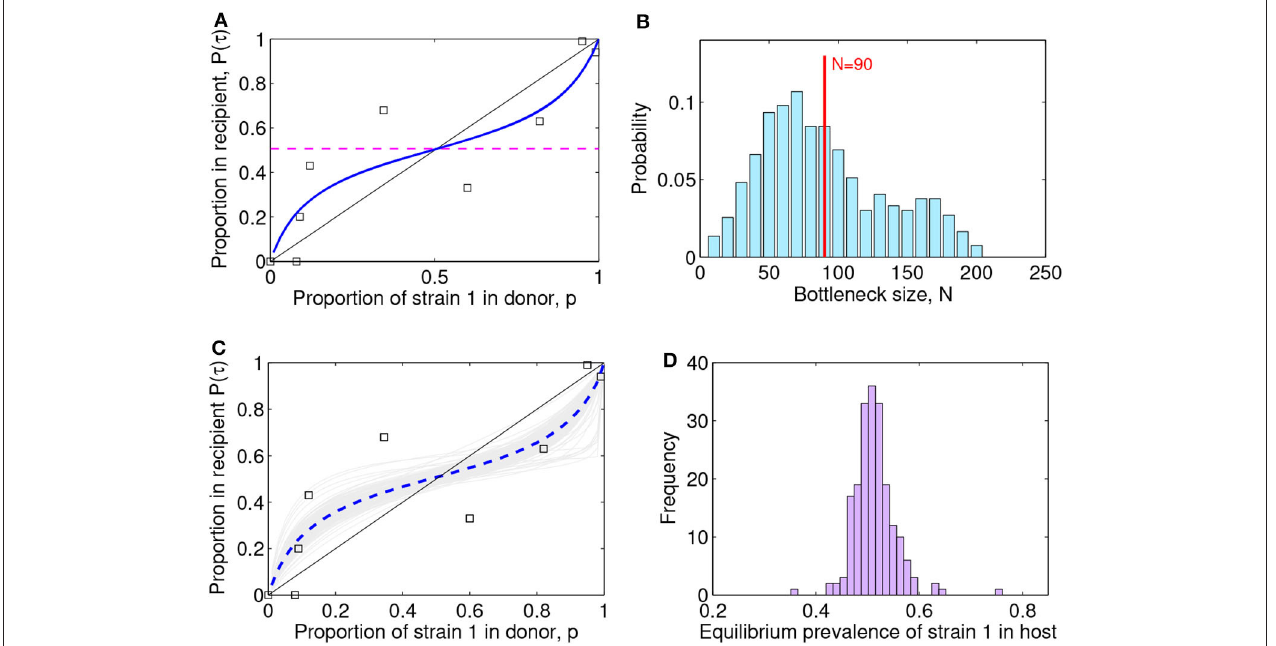
FIGURE 4 | Lotka-Volterra model fit to the (McCaw et al., 2011) ferret transmission data. (A) Fit result with best parameter estimate [ ρ , a 12 , a 21 , β ] = [1.00, 0.25,0.31,0.94], MSE = 0.022. The squares indicate the data, the blue line the model fit, and the dashed purple line the predicted within-host coexistence equilibrium between the two strains. (B) Maximum-likelihood bottleneck size estimation N after filtering simulations and fits. The values of N ∈ [10,200] were ranked based on: (i) the model quality of fit (mean-squared-error of new fit within 20% of the original MSE) and (ii) the capture of the data (proportion of original data points contained within the range of ten N -based stochastic simulations). We multiplied the two criteria for ranking N , and applied a moving average to smooth over N , and a standard normalization to transform the values into probabilities. The mean value estimated for the bottleneck is N = 90 (vertical red line) and the standard deviation is 45, thus suggesting the range N ∈ (45,135) as the most compatible with these data and this model. The mode of the distribution is N = 70. (C) Visualization of 200 model fits (gray lines) to simulated data, varying the initial proportion transmitted from donor to recipient according to bottleneck sizes N sampled from the distribution in (B) . The dashed blue line indicates the mean over all the simulation fits. The squares indicate the data. (D) Model predictions for the within-host prevalence of the mutant strain in coexistence (Equation 8), integrating stochasticity and variation expected from N in (C) . TABLE 1 | Summary of parameter estimates from nonlinear least squares optimization, applying the model to the original data ( Figure 4A ), without considerations of bottleneck size, and fits to simulations with an explicit bottleneck size N ( Figure 4C ), all leading to similar mean-squared-error (MSE) and predictions for within-host prevalence between the two strains. ρ a 12 a 21 β MSE Equilibrium p ∗